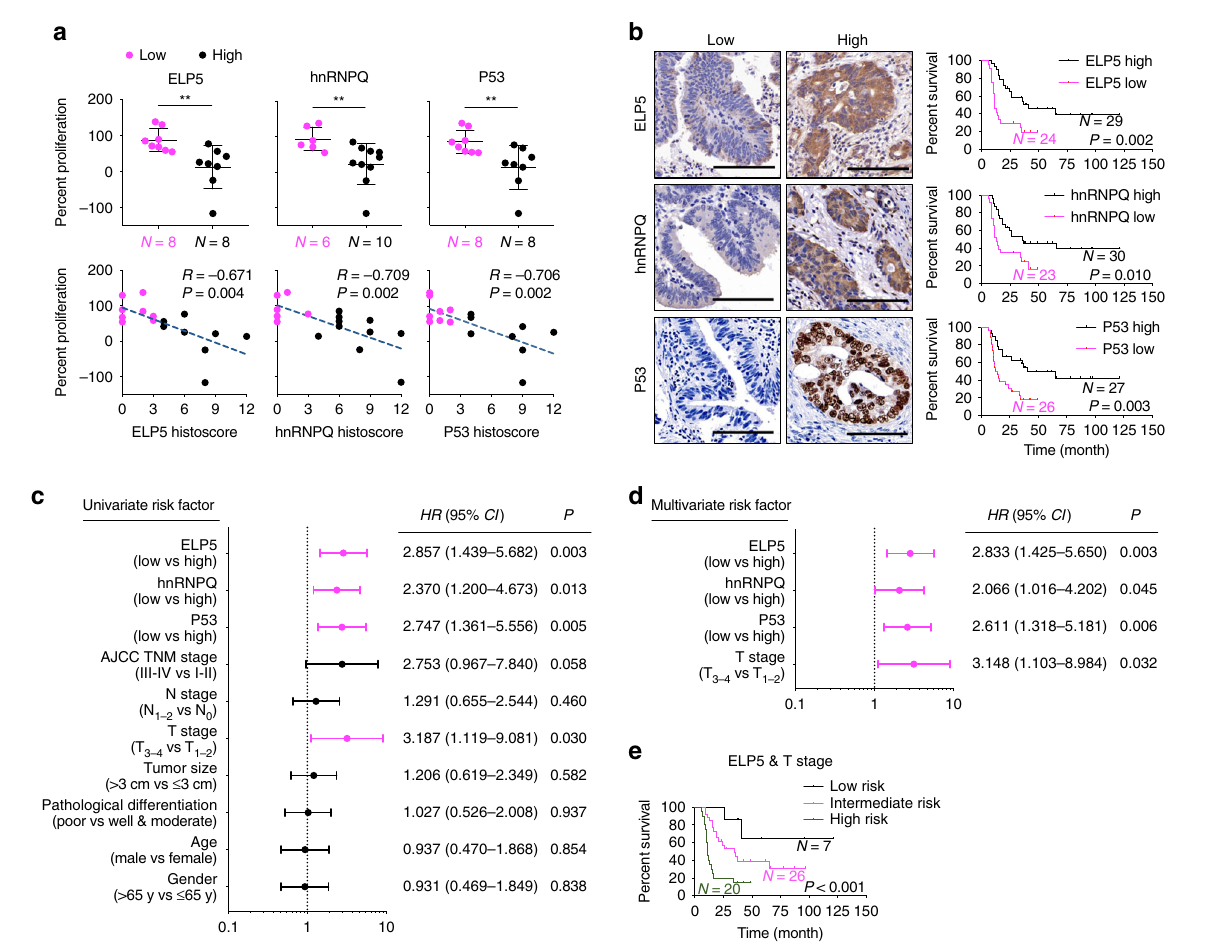
Fig. 7 Low expression of Elongator/hnRNPQ/P53 is correlated with poor gemcitabine sensitivity and poor survival outcomes in GBC patients. a ELP5, hnRNPQ, and P53 expression assessed by histoscore were negatively correlated with the proliferation rate of GBC primary tumor cells under GEM treatment in mini-PDX models (Cohort 1), as normalized to vehicle treatment. Data represent the mean ±S.D, error bars represent S.D. b Kaplan – Meier estimate of survival time in GBC patients who received gemcitabine-cisplatin therapy after surgery (Cohort 2) according to different ELP5, hnRNPQ, and P53 levels in paraf fi n- fi xed tumorous specimens. Scale bars = 100 μ m. c , d Univariate ( c ) and multivariate ( d ) Cox regression analyses were performed in Cohort 2. The bars represent 95% CI . CI , con fi dence interval; HR , hazard ratio. e Kaplan – Meier estimate of survival time in GBC patients who received gemcitabine-cisplatin therapy after surgery (Cohort 2) based on combined ELP5 and T stages: low risk (high ELP5 and early T stage), intermediate-risk (low ELP5 and early T stage, or high ELP5 and advanced T stage), and high-risk (low ELP5 and advanced T stage) groups. Early T stage, T 1~2 ; advanced T stage, T 3~4 . Mann – Whitney U tests were used in a (upper panel), the Pearson correlation coef fi cient were used in a (down panel), and log-rank tests were used in b , e